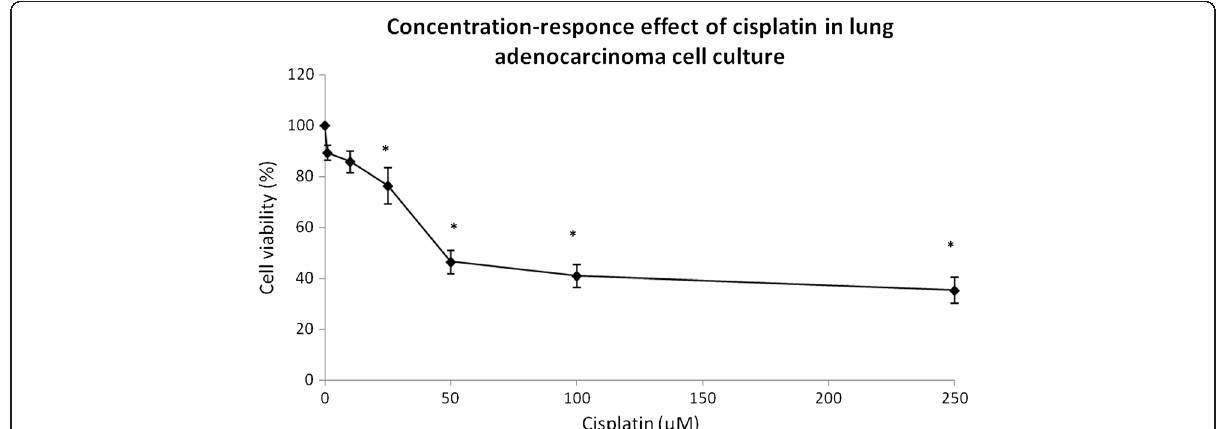
Figure 3 Concentration-response effect of cisplatin on lung adenocarcinoma cell culture: cell viability was measured by MTT assay. Data are expressed as the mean ± SD of four independent experiments. * p < 0.01 vs. control, one-way analysis of variance, with Bonferroni ’ s